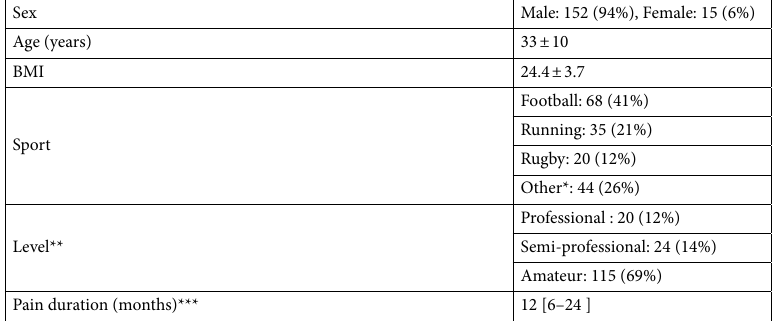
Table 1. Patient demographics (n = 167). Data presented as mean ± SD, median [interquartile range] or number (percentage). * Other sports included more than 20 different sports.** 8 athletes (5%) did not report their level of sport. *** 22 athletes (13%) had missing data on pain duration. Ten patients had a pain duration less than 3